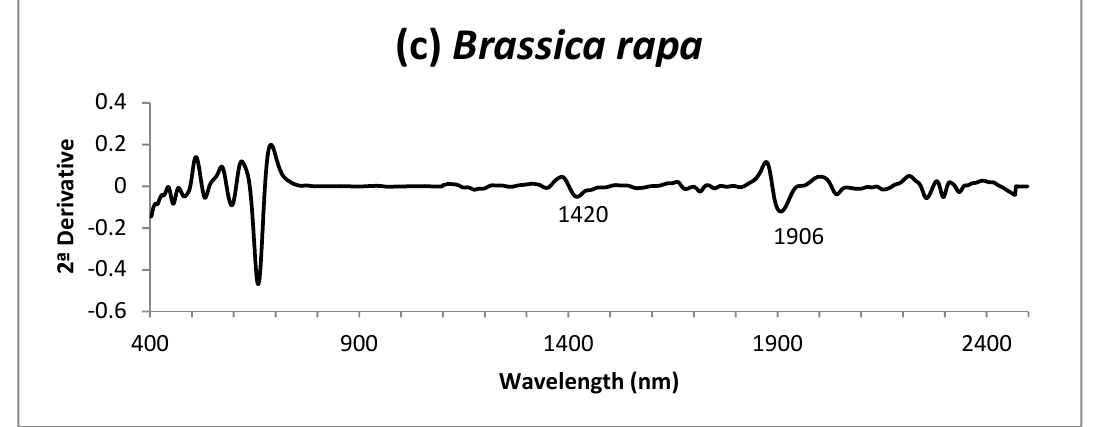
Figure 3. ( a ) Mean spectrum of the lyophilized green parts of Brassica rapa ; ( b ) first derivative (SNV-DT) of the mean spectrum of the lyophilized green parts of Brassica rapa ; ( c ) second derivative (SNV-DT) of the mean spectrum of the lyophilized green parts of Brassica rapa .